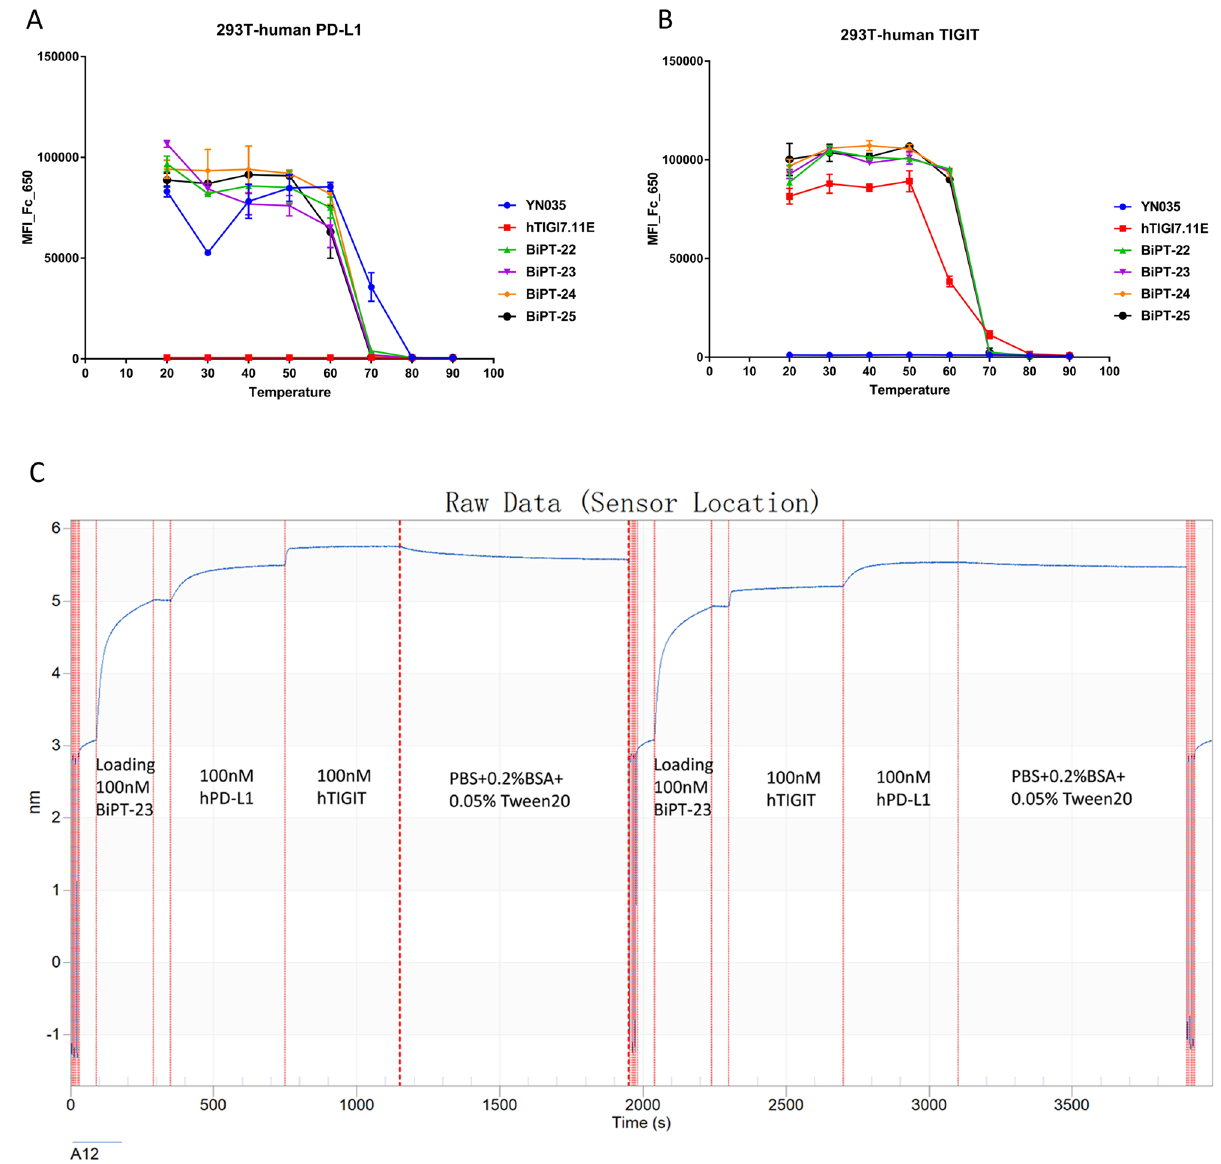
Figure 4. The stability assay of BiPT-22-25. ( A ) After the heating challenge at variable temperatures, 25 nM antibodies were incubated with PD-L1-overexpressing 293 T cell line to determine their binding ability. ( B ) After the heating challenge at variable temperatures, 25 nM antibodies were incubated with TIGIT- overexpressing 293 T cell line to determine their binding ability. ( C ) BiPT-23 could bind PD-L1 and TIGIT simultaneously in the ForteBio Octet